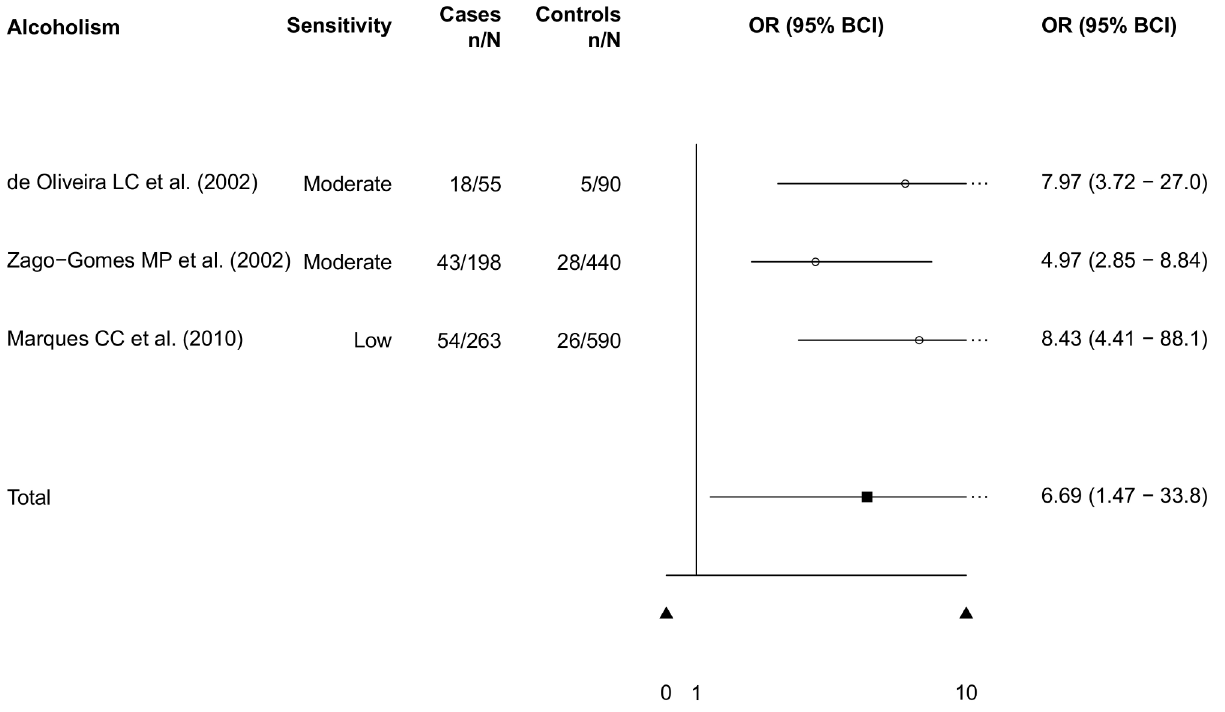
Figure 9. Risk of S.stercoralis infection in alcoholics (meta-analysis of case-control studies).